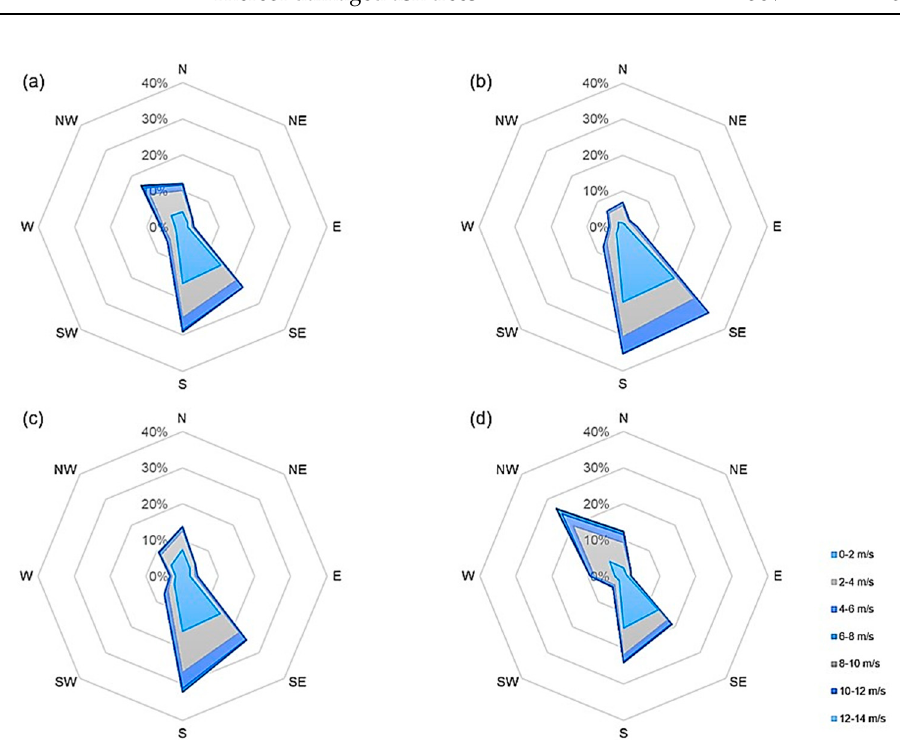
Figure A1. Wind rose during the measurement campaign in 2019 at the location Schorndorf for the periods ( a ) total: 18.03–14.05, ( b ) pre-flowering: 18.03–02.04, ( c ) main flowering: 02.04–23.04, ( d ) post-flowering: 23.04–14.05.